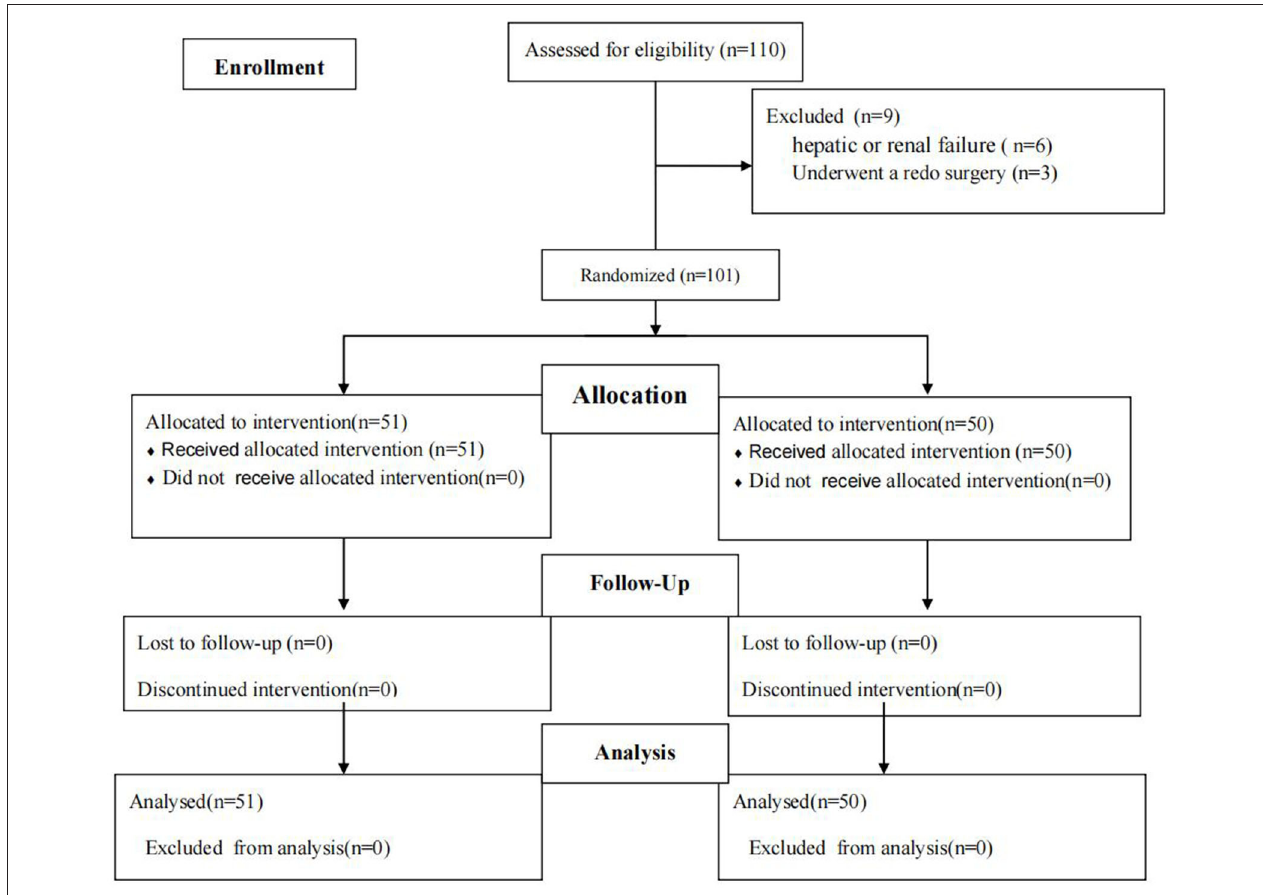
FIGURE 1 | Patient flow diagram.